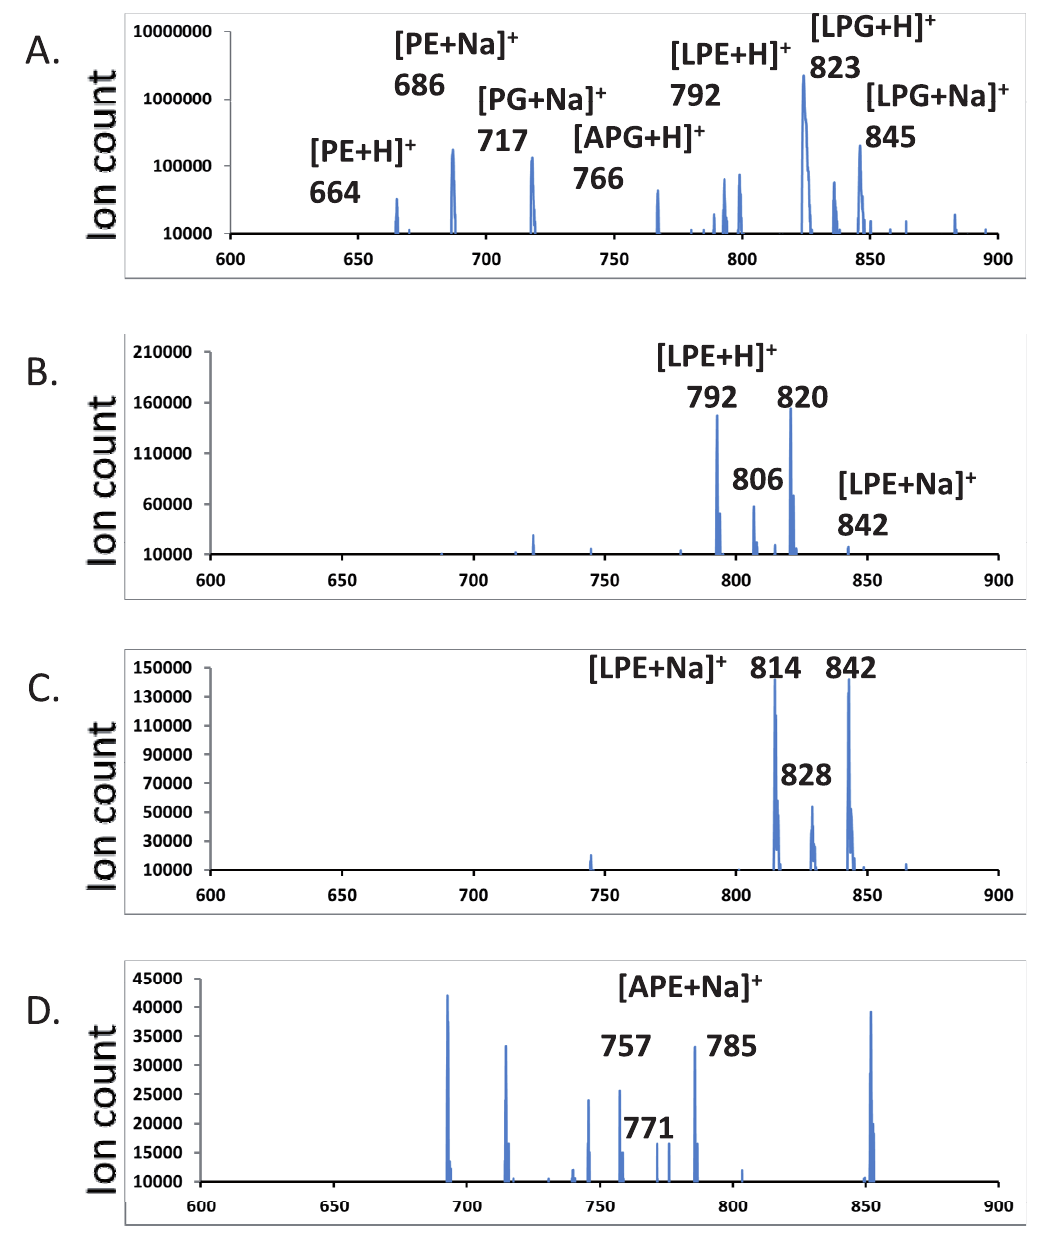
Figure 4. Neutral loss and precursor scans for aminoacyl-PEs. Major peaks in the MS/MS spectra are labeled. LPG – lysyl-PG, APG – alanyl-PG, LPE – lysyl-PE, APE – alanyl-PE. A . Scan for precursors of a 523.3 amu DAG fragment. B . Scan for a neutral loss of a 269.1 amu fragment. C . Scan for precursors of a 292.1 amu fragment. D . Scan for precursors of a 235.1 amu